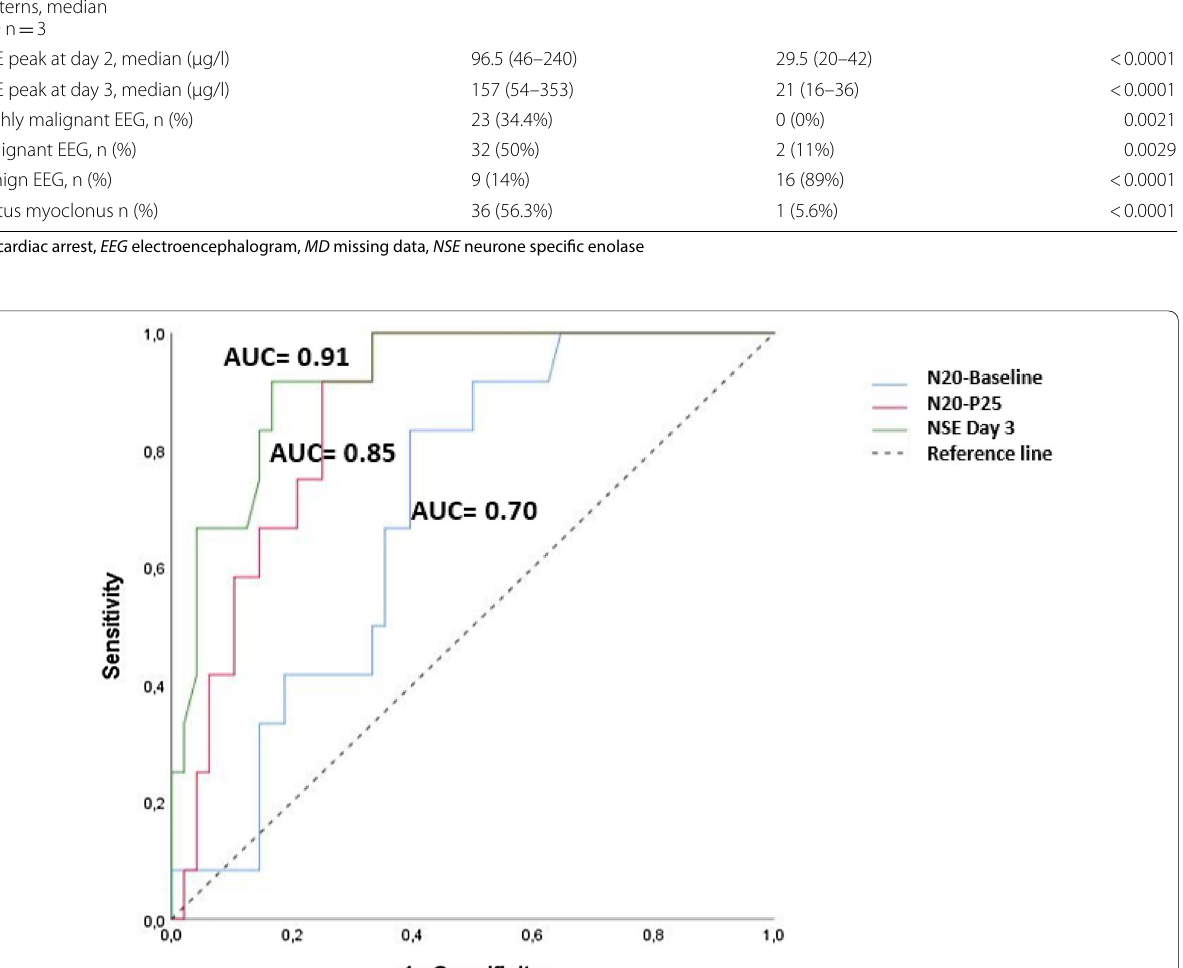
0.91 (0.85–0.98), p < 0.0001; N20‑P25 =